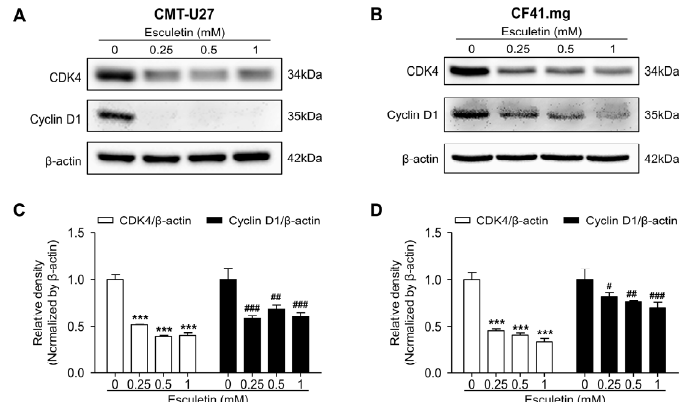
Figure 6. Esculetin downregulates the cell cycle-related proteins. ( A – D ) Images and quantification of the protein expression of CDK4 and cyclin D1 in CMT-U27 ( A , C ) and CF41.mg ( B , D ) cells after esculetin treatment. Values are mean ± SD. *** p < 0.001; # p < 0.05, ## p < 0.01, ### p < 0.001 versus untreated cells by one-way ANOVA followed by Bonferroni post-test.